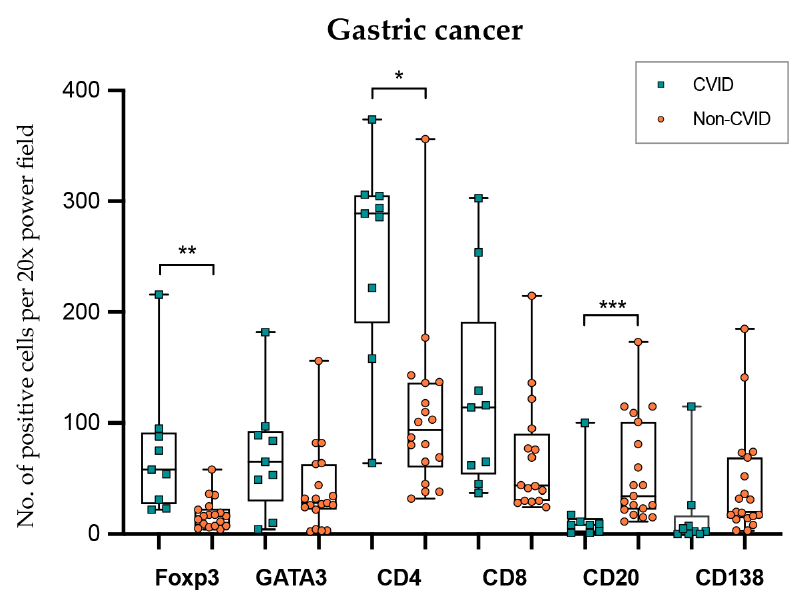
Figure 6. Lymphocyte counts in gastric cancer from CVID and non-CVID patients. Statistically significant results are highlighted by asterisks: * p ≤ 0.05; ** p ≤ 0.01; *** p ≤ 0.001.